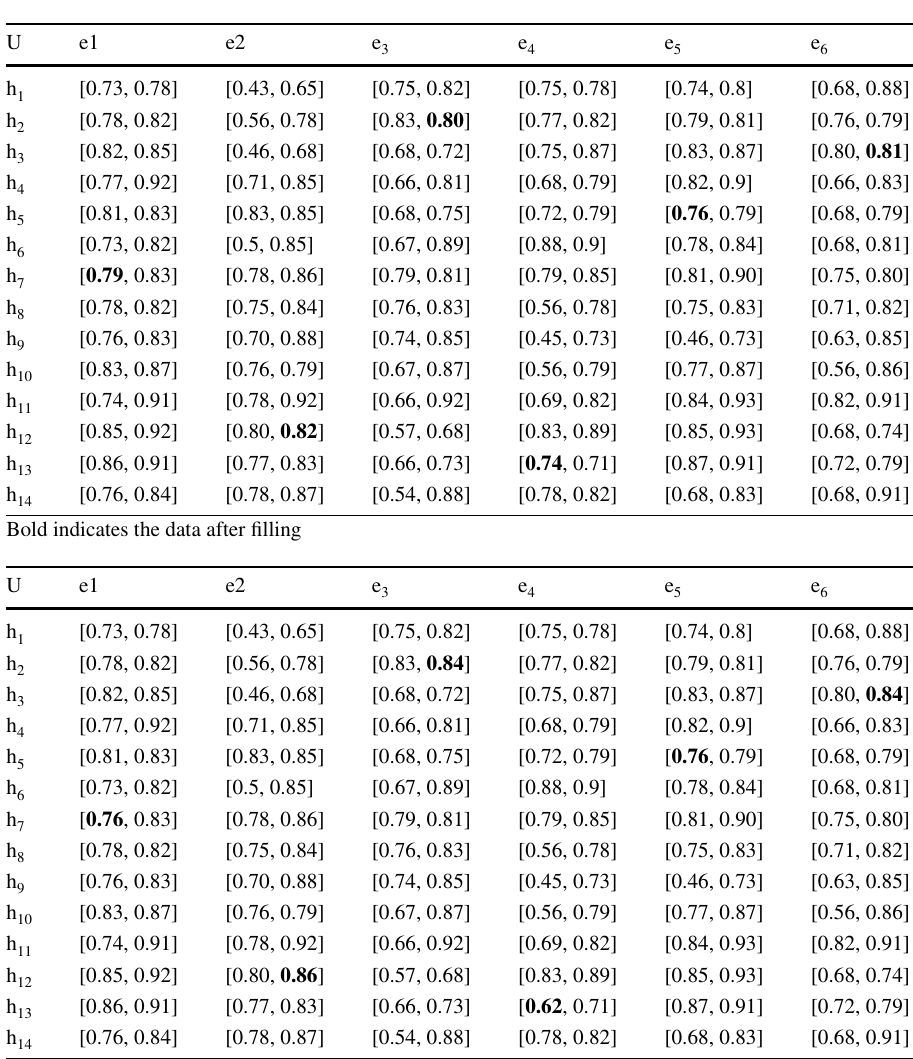
Bold indicates the data